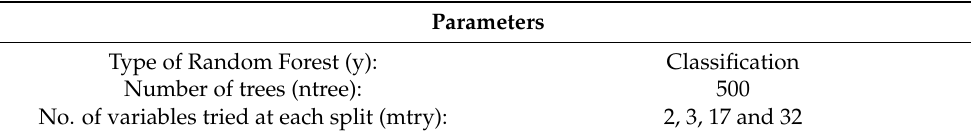
Figure 1. Flowchart of the proposed methodology. Table 2. Random Forest